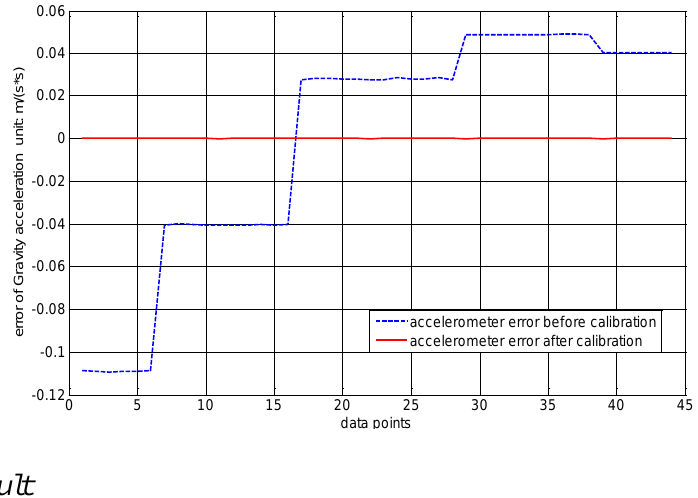
Figure 7. The accelerometer error before calibration and after calibration.